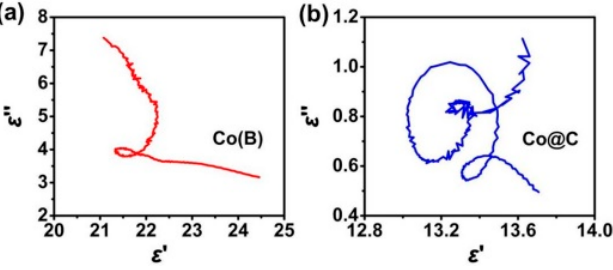
Figure 2. Plots of ε″ versus ε′ for ( a ) metallic Co and ( b ) core–shell Co@C microspheres. Reprinted with permission from Reference [46].